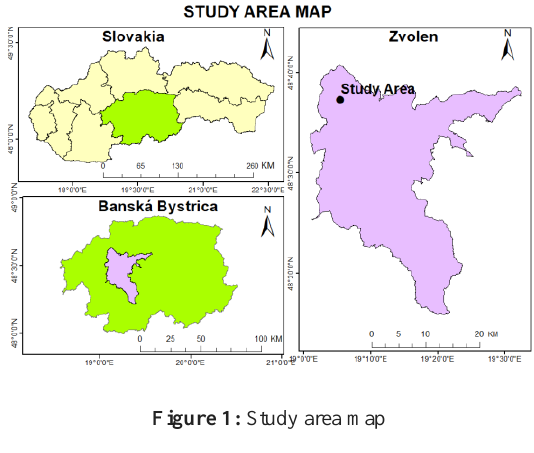
Figure 1: Study area map